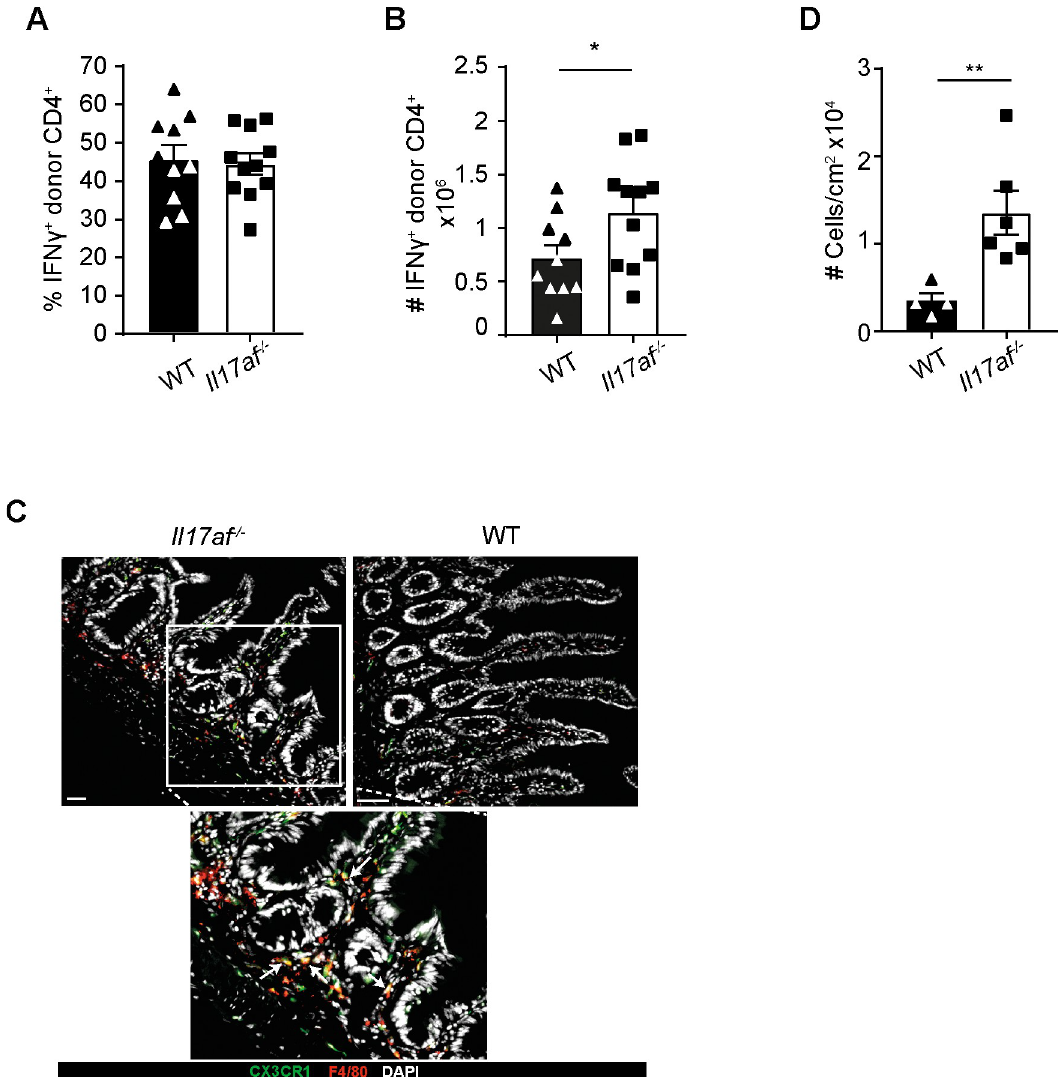
Fig 5. Lack of IL-17 causes CD4 + IFN γ + and macrophage infiltration. BALB/c mice were lethally irradiated and transplanted with 5x10 6 TCD BM and 0.5x10 6 CD4 + cells from BL6 WT or Il17af -/- donors. A) FACS sorted donor Thy1.1 + CD4 + T cells from the SI of the BALB/c mice stained for the expression of the IFN γ on day 21 post BMT. Gating was performed on donor lymphocytes using Thy1.1 as congenic marker. Each dot represents the total amount of cells isolated from the organ of a single mouse; the bars show the mean (WT n = 10; Il17af -/- n = 11). B) Representative staining for macrophage infiltrates in the small intestine of BALB/c recipients on day 21 after BMT. Arrows indicate DAPI + CX3CR1 + F4/80 + cells. Scale bars represent 50 μ m C) Absolute number of DAPI + CX3CR1 + F4/80 + cells per cm 2 . (WT n = 4; Il17af -/- n = 6) All data are pooled from two or three independent experiments. Error bars represent SEM. For statistical analysis, non-parametric two-tailed T test was used. � p � 0.05; �� p �